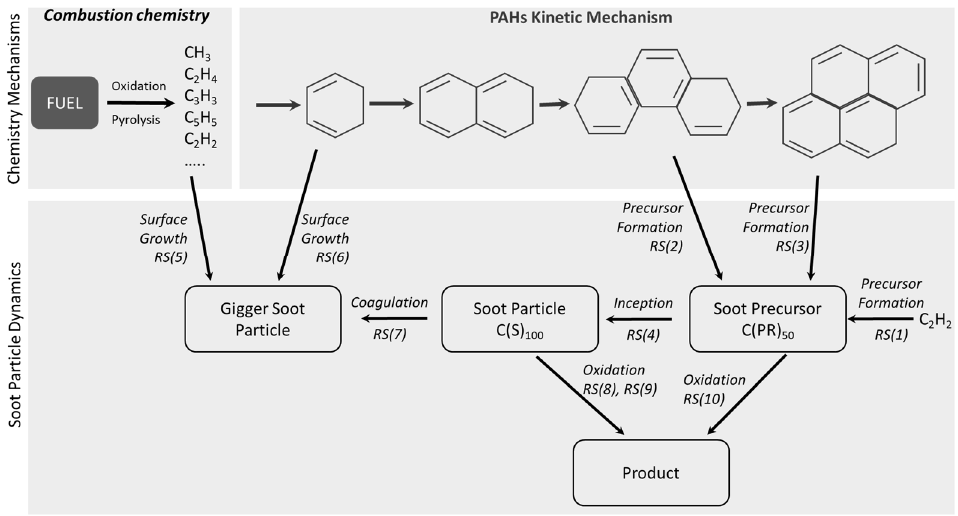
Figure 7. Soot formation pathways from fuel combustion adapted from several sources in the liter- ature